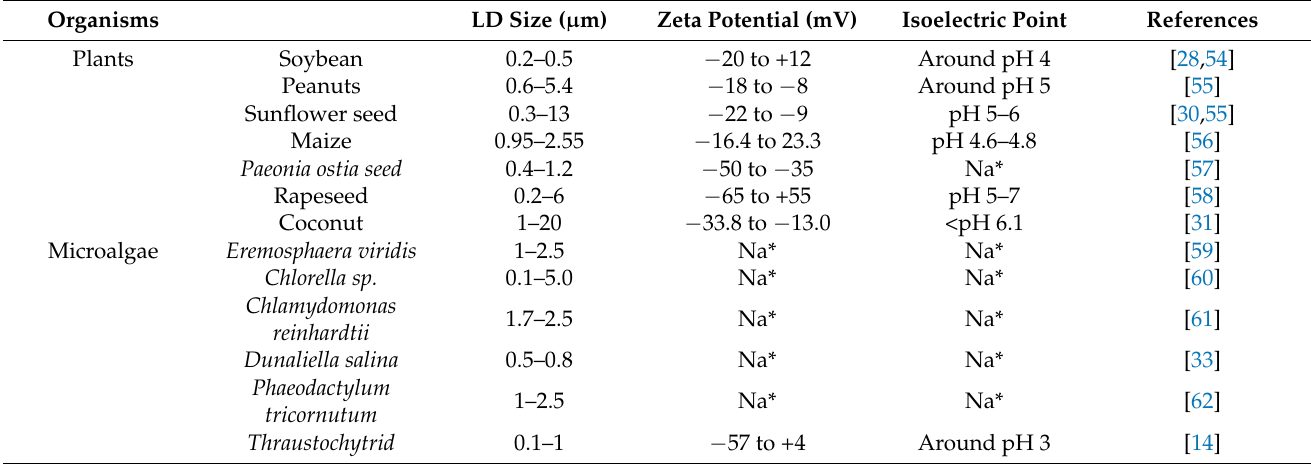
Table 2. A summary of the information on lipid droplets from plants and